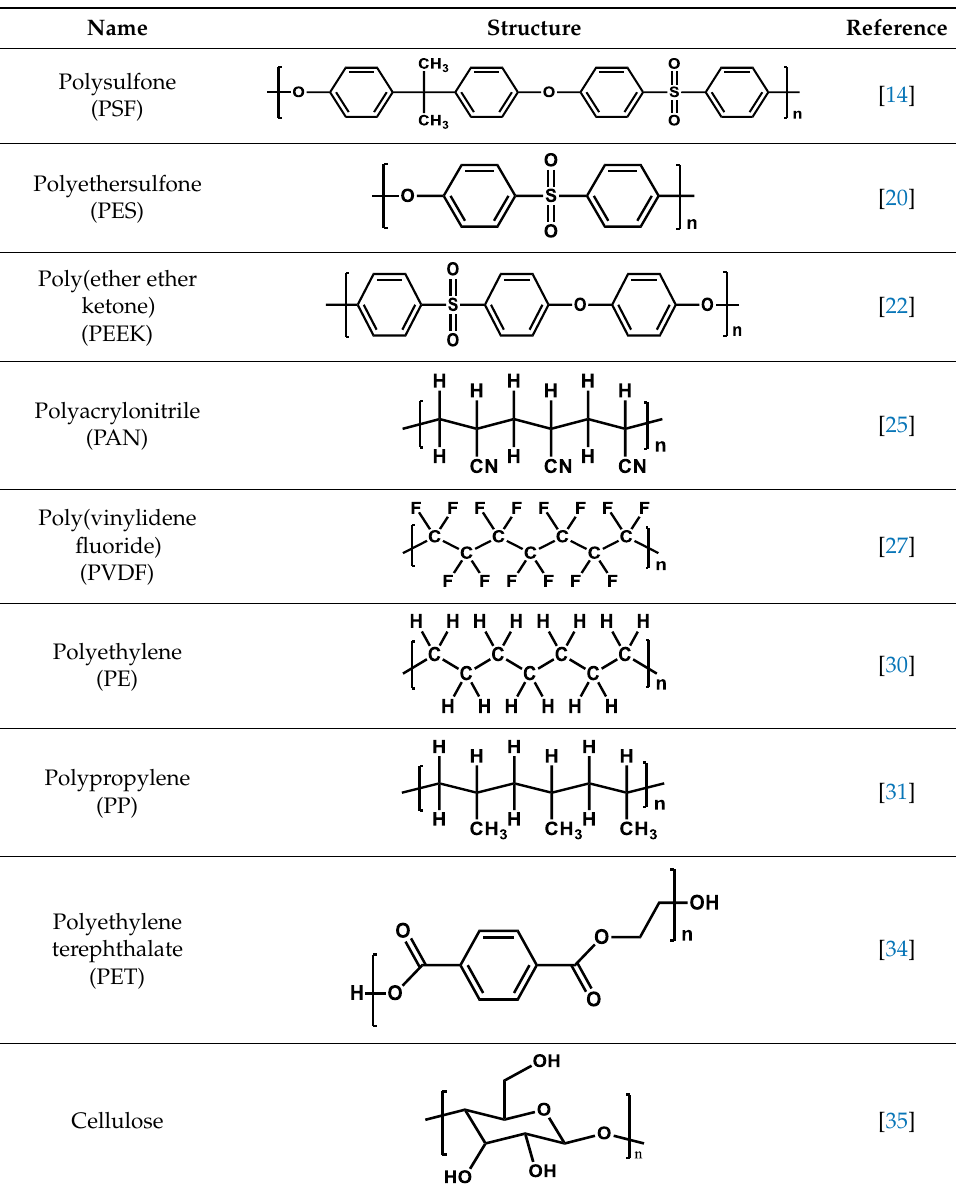
Table 1. Chemical names and structures of common support membranes.